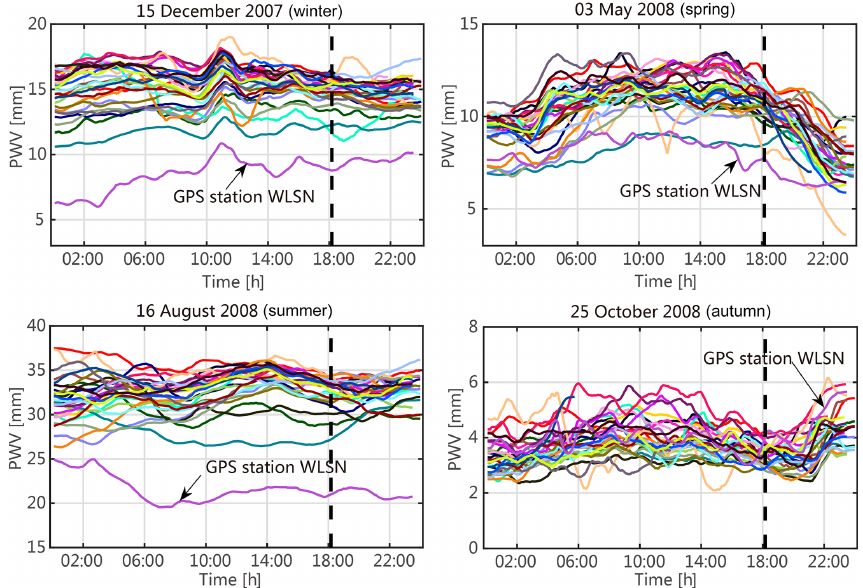
Figure 6. Time series over 24h of PWV estimated from GPS observations at 29 GPS stations located in the study area (as shown in Fig. 1) on four SAR acquisition dates. The vertical black dashed lines represent the SAR satellite overpass time (18:01UTC). Black arrows on each plot indicate the locations of GPS station WLSN (altitude about 1700) on Mount Wilson. In general, the higher the GPS station, the lower the PWV